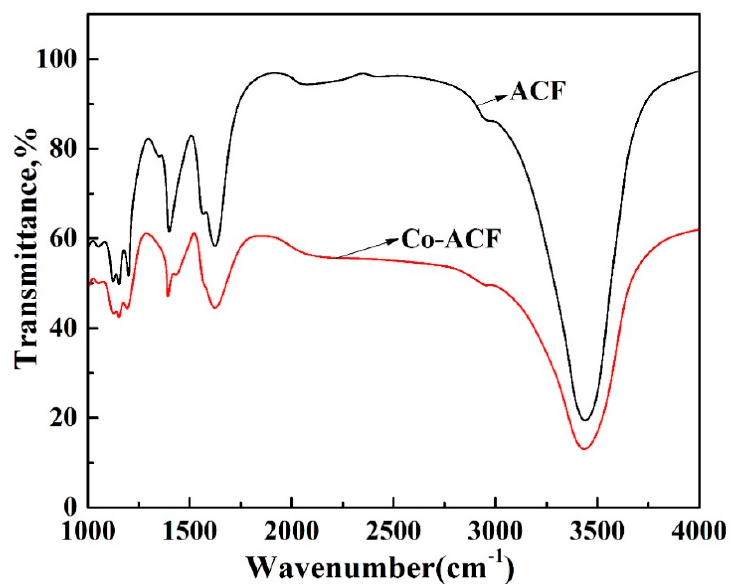
Figure 3. FT-IR spectra of ACFs and 40% Co-ACFs.